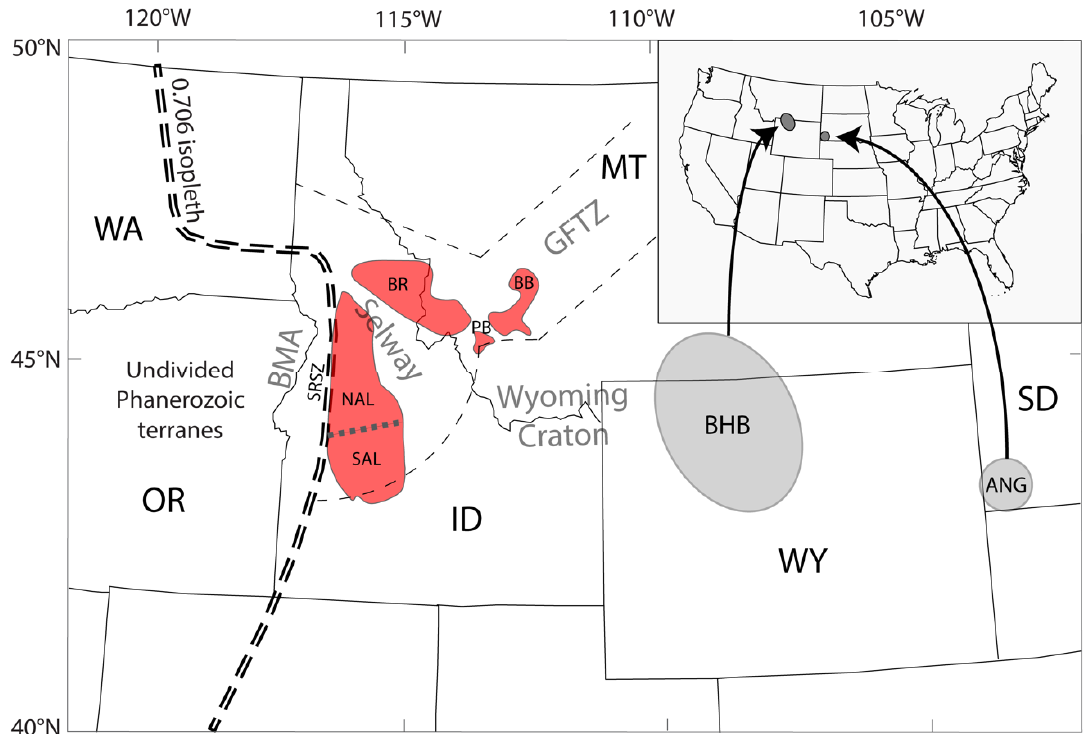
Figure 1. Location maps for this study. Inset map shows location of bentonite beds collected from the Bighorn Basin (BHB) in north-central Wyoming and near the Angostura Reservoir (ANG) in southwestern South Dakota (see [11] for more detailed locations). Larger map shows simplified locations of the Idaho batholith, including the Southern Atlanta lobe (SAL), Northern Atlanta lobe (NAL) and the Bitterroot lobe (BR), in addition to the Boulder batholith (BB); the 0.706 Sr isopleth, the isotopic boundary separating Laurentia from exotic and accreted terranes now exposed in the Blue Mountains. Generalized boundaries drawn with dashed lines for various basement terranes. Other abbreviations: BMA = Blue Mountain Arcs; GFTZ, Great Falls Tectonic Zone; PB = Pioneer Batholith; SRSZ = Salmon River Suture Zone.